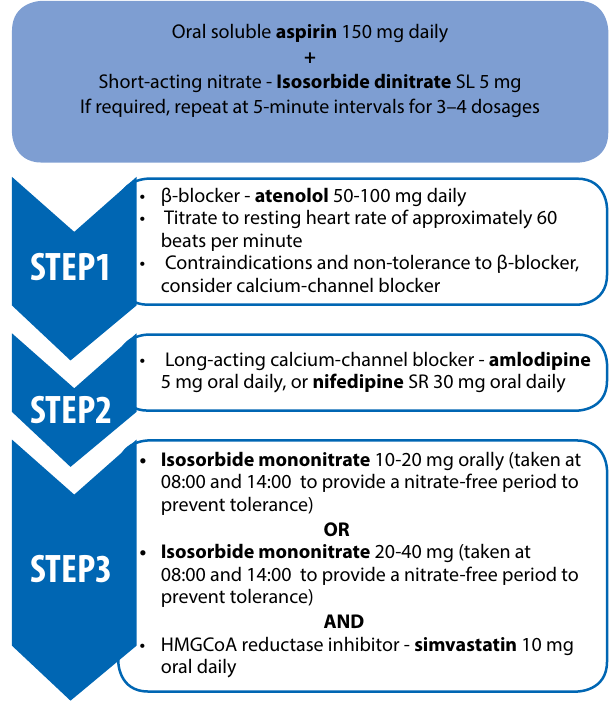
Figure 1: Treatment of Stable Angina Pectoris according to the Standard Treatment Guidelines/Essential Medicines List (STG/EML)